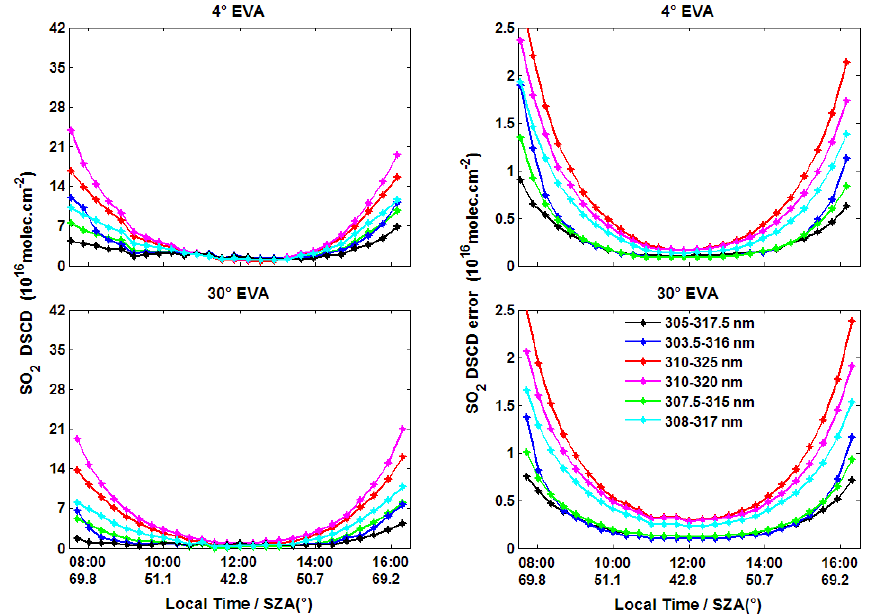
Figure 2. SO 2 DSCDs (first column) and corresponding fitting uncertainties (second column) retrieved at 4 ◦ (upper plots), 30 ◦ (lower plots) elevation (EVA) for different wavelength intervals on 1 October 2011. Local time (h) and corresponding SZA ( ◦ ) are given on the x axis.